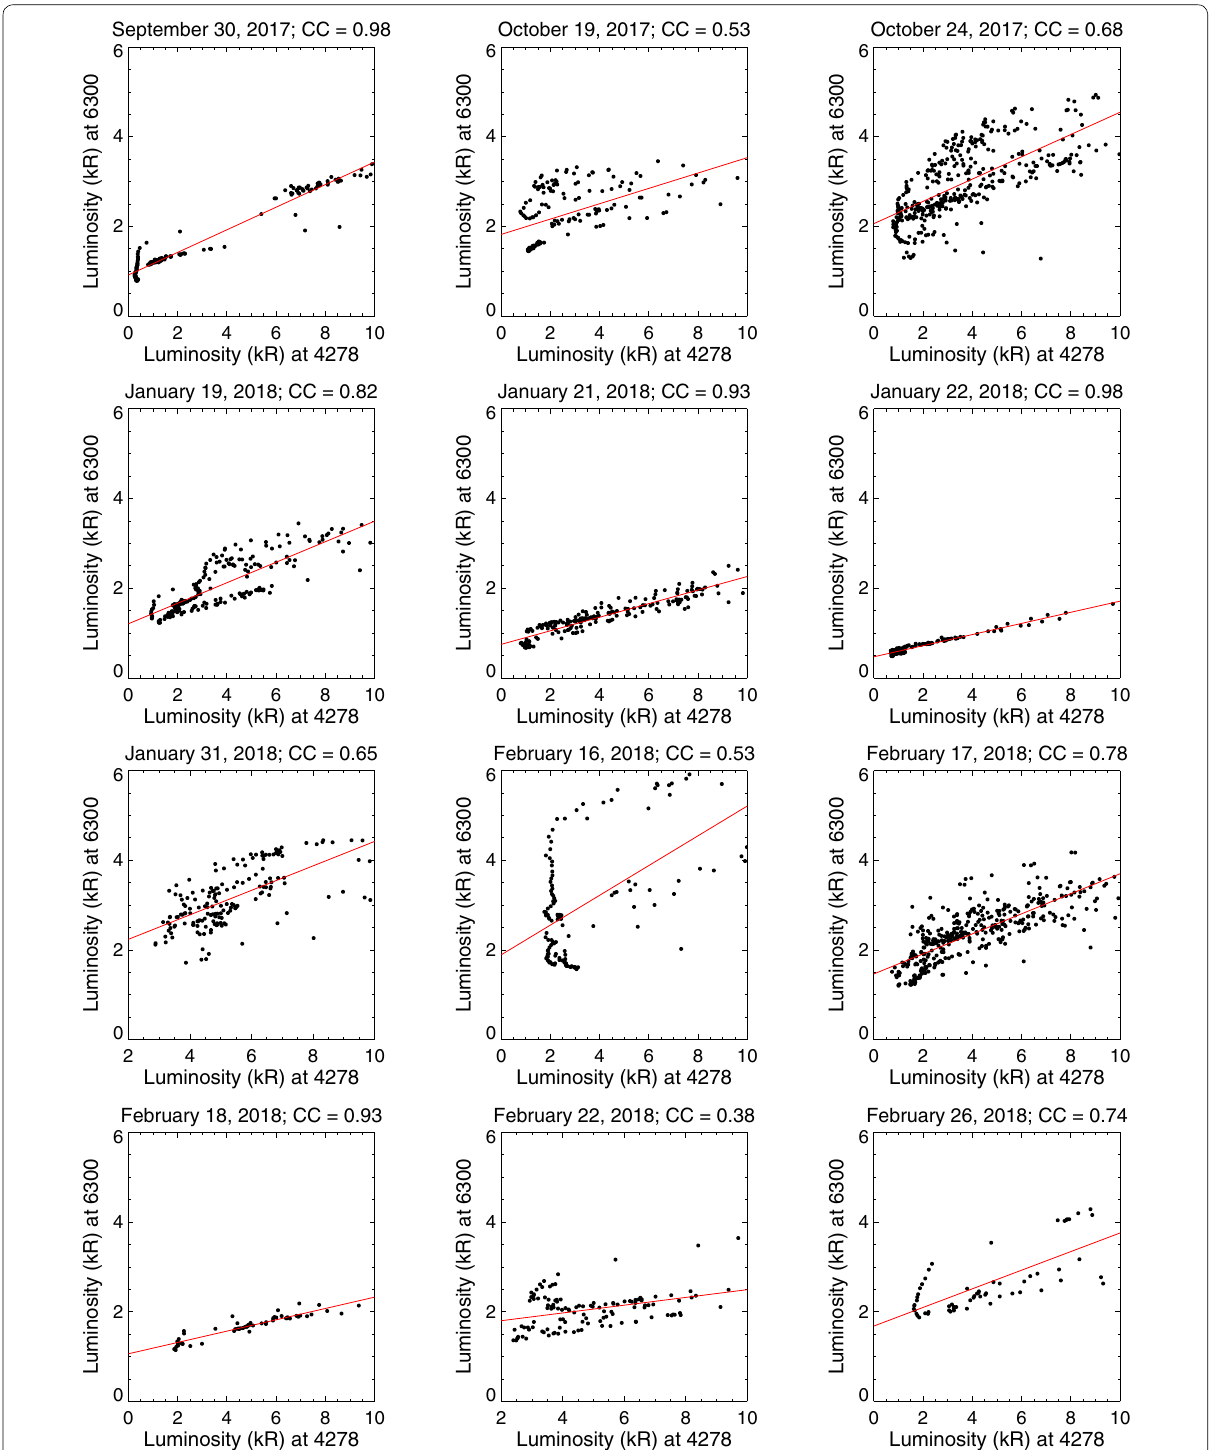
Fig. 24 Scatter plots between 427.8 nm (< 10 kR) and 630 nm emission luminosities; This figure is the same as Fig. 23, except for the conditions where the luminosity the conditions where the luminosity of the 427.8 nm intensity is less than 10